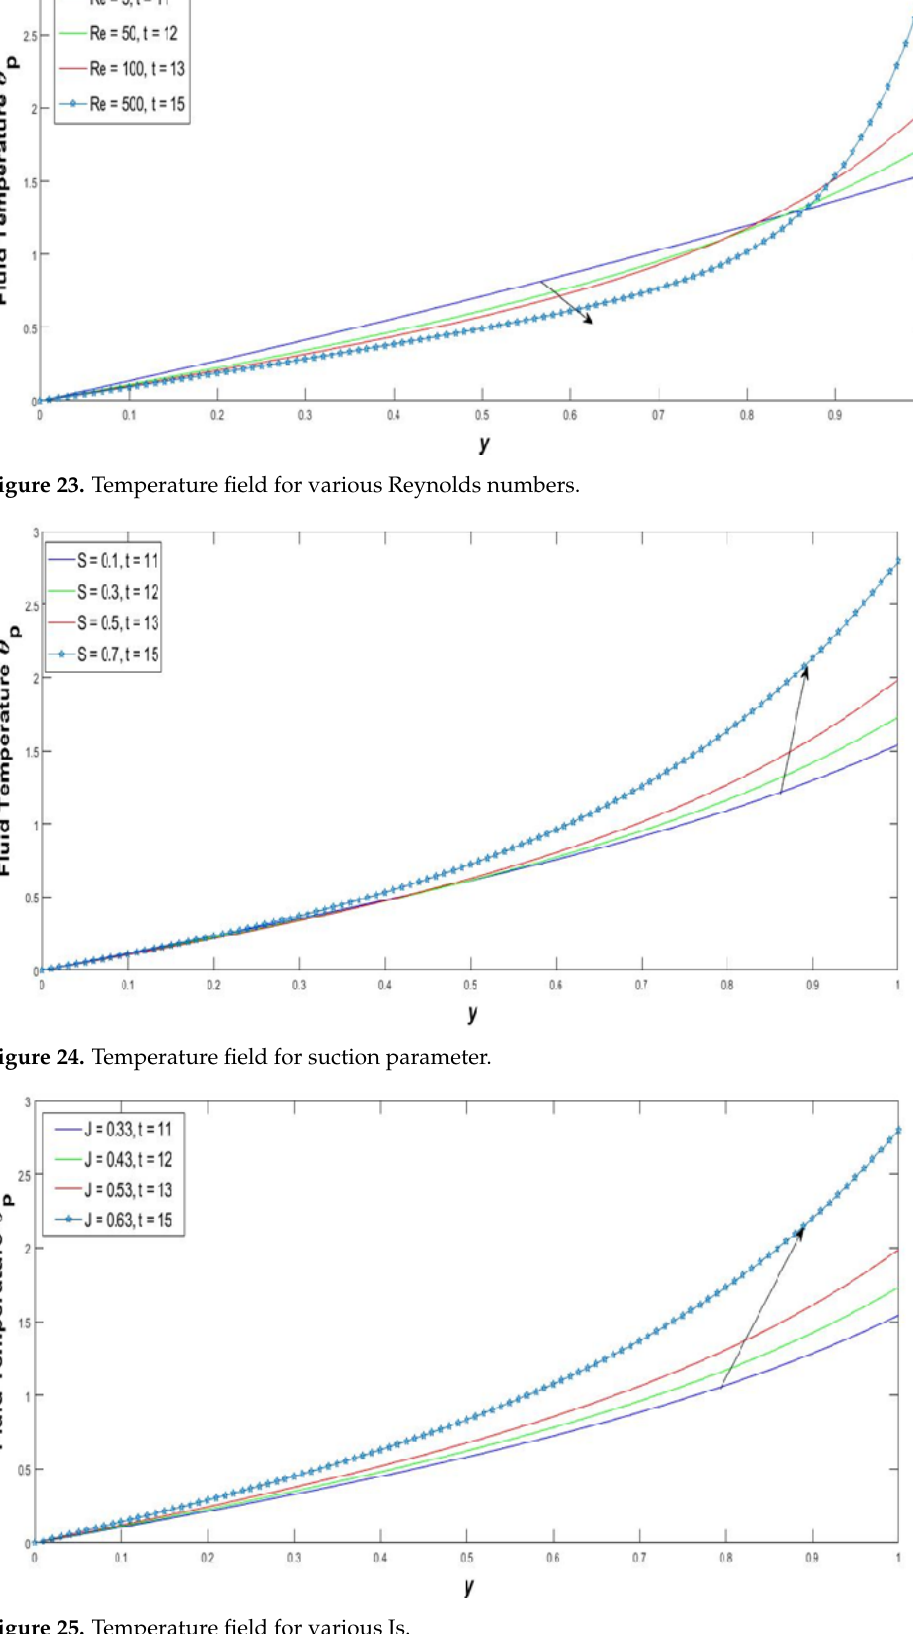
Figure 25. Temperature field for various